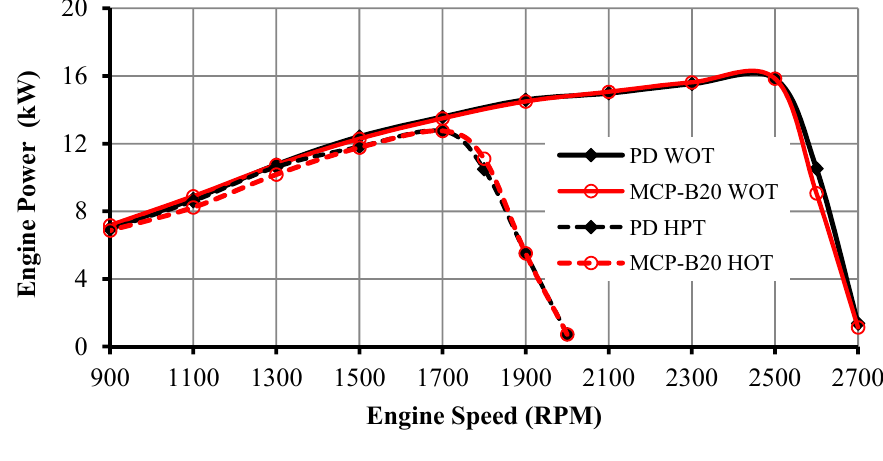
Figure 4. The relationship between tractor engine speeds (RPM) and engine power (kW) for PD and